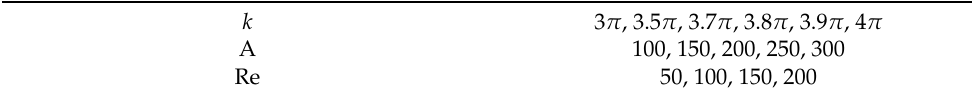
Table 1. Physical parameters used in the